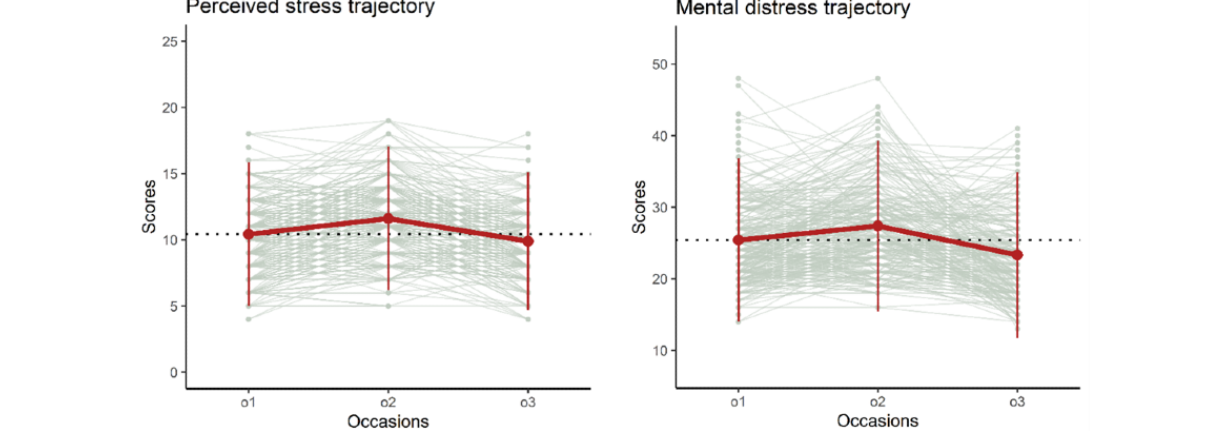
Figure 2. The left panel depicts the perceived stress (sum score mean level) trajectory and the right panel depicts the mental distress (sum score mean level) trajectory. The faded gray lines indicate person-level trajectories. The red line indicates the group-level sum score trajectory, which was averaged across the students. The dotted black line represents the group-level sum score for occasion 1. This was done solely to enhance the comparison